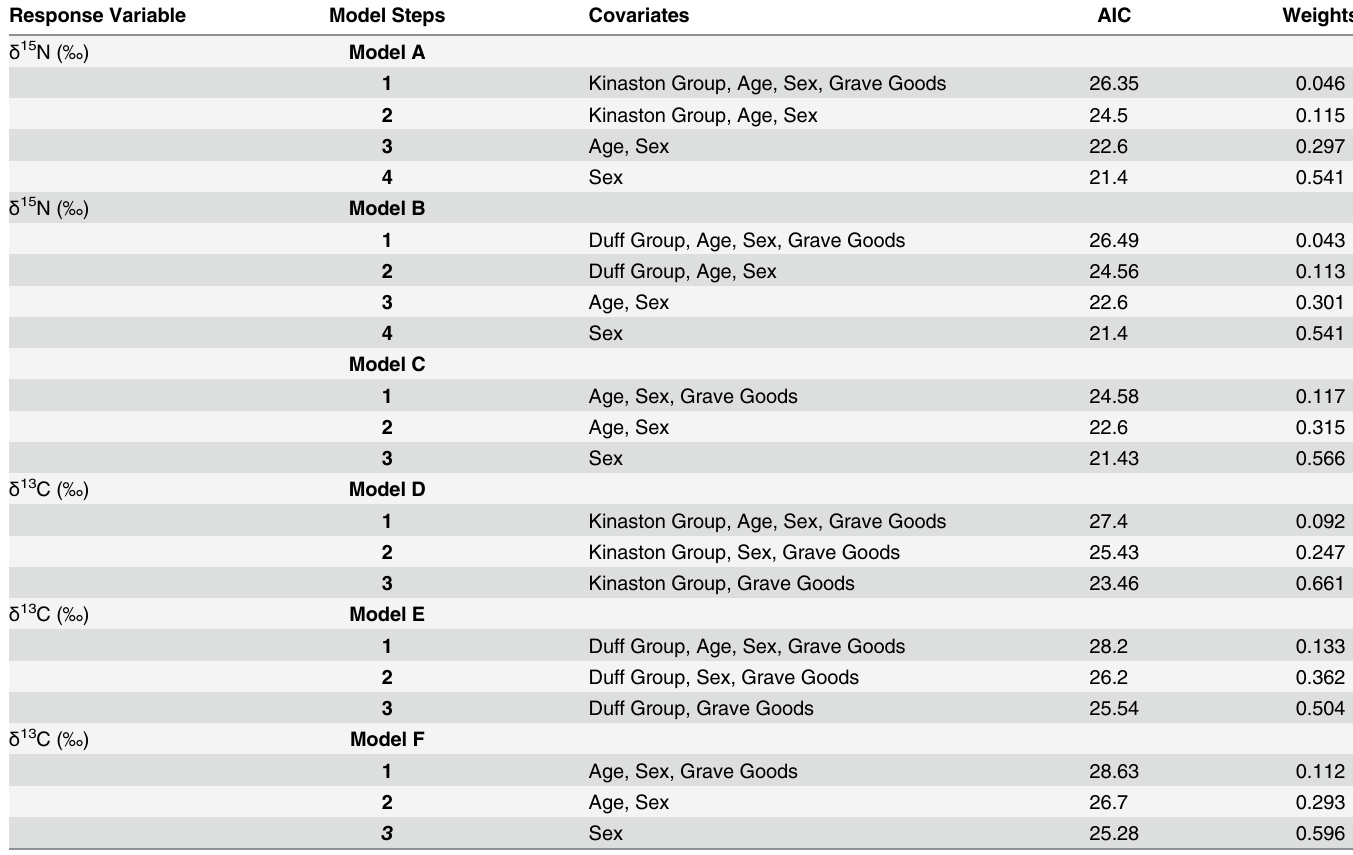
Table 1. Model selection using Akaike Information Criterion